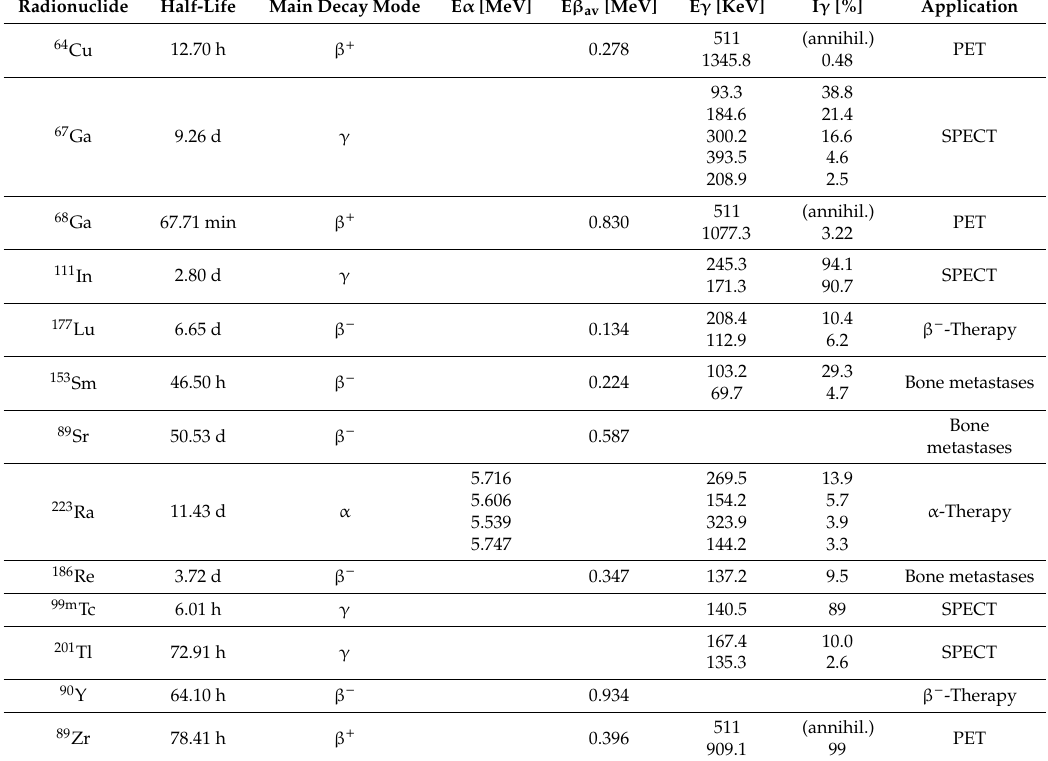
Table 1. Decay characteristics and applications of radiometals currently used in clinical practice (decay data are taken from [22] and only the main γ -emission lines are